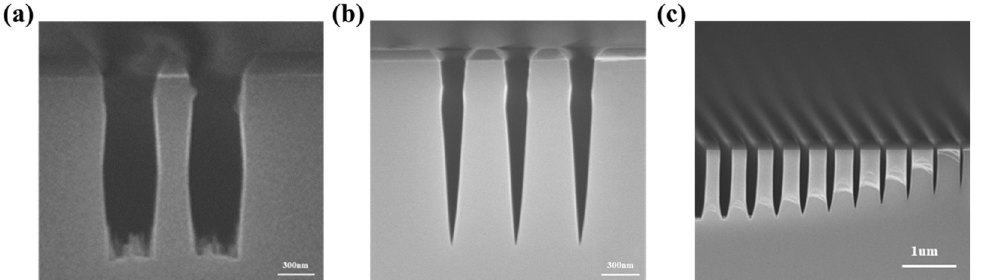
Figure 2. The common phenomena in our etching process development: ( a ) Rough surface in grooves. ( b ) Sidewall slope (~85°) on pillars. ( c ) The ARDE effect in dry etching.